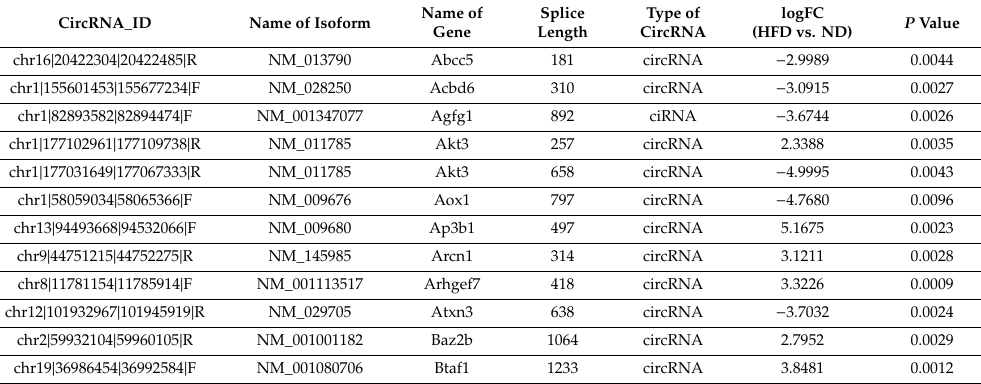
Figure 2. Di ff erential expression and validation of circular RNA derived from the insulin 2 gene. ( A ) Volcano plot of di ff erentially expressed circRNAs detected by CIRCexplorer2 in pancreatic islets of mice fed with HFD compared to ND. The log2 fold-change greater than 2 and p -value less than 0.01 were considered as di ff erentially expressed. The upward and downward arrows indicate up- and downregulated circRNAs, respectively. ( B ) Heatmap representing hierarchical clustering of di ff erentially expressed circRNAs, as mentioned in panel A. Three circRNAs derived from Ins2 are labeled on the heatmap. ( C ) Schematic representation of mouse Ins2 pre-mRNAs and the location of divergent primers for amplification of circ-Ins2, and ci-Ins2. The boxes represent the exons, and the lines represent the introns. The dotted curved lines represent the backsplicing or intron lariat junctions. ( D ) The RT-PCR products of Ins2, circ-Ins2, and ci-Ins2 in β TC6 cells resolved and visualized in SYBR Gold-stained 2.5% agarose gel. ( E ) PCR products of ci-Ins2 from β TC6 cells were purified and Sanger-sequenced to confirm the junction sequences of ci-Ins2 transcripts. Table 1. List of di ff erentially expressed circRNAs detected with CIRCexplorer2.